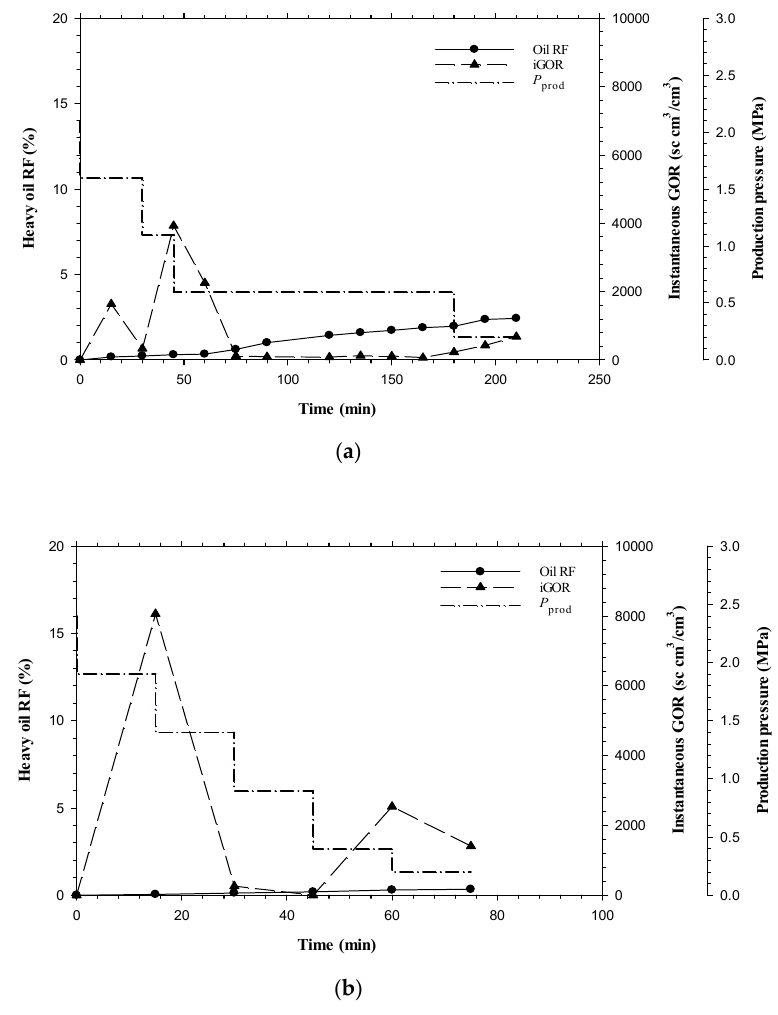
Figure 6. Measured heavy oil recovery factors (RFs), instantaneous gas-oil ratios (iGORs), and production pressures ( P prod ) in CO 2 -CSI process at ∆ P EOR = 0.5 MPa (Test #2) ( a ) Cycle #1; and ( b ) Cycle #2.